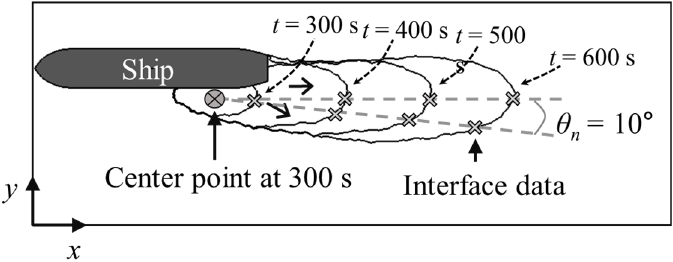
Figure 5. Schematic showing the interface of styrene and the interface propagation velocity.